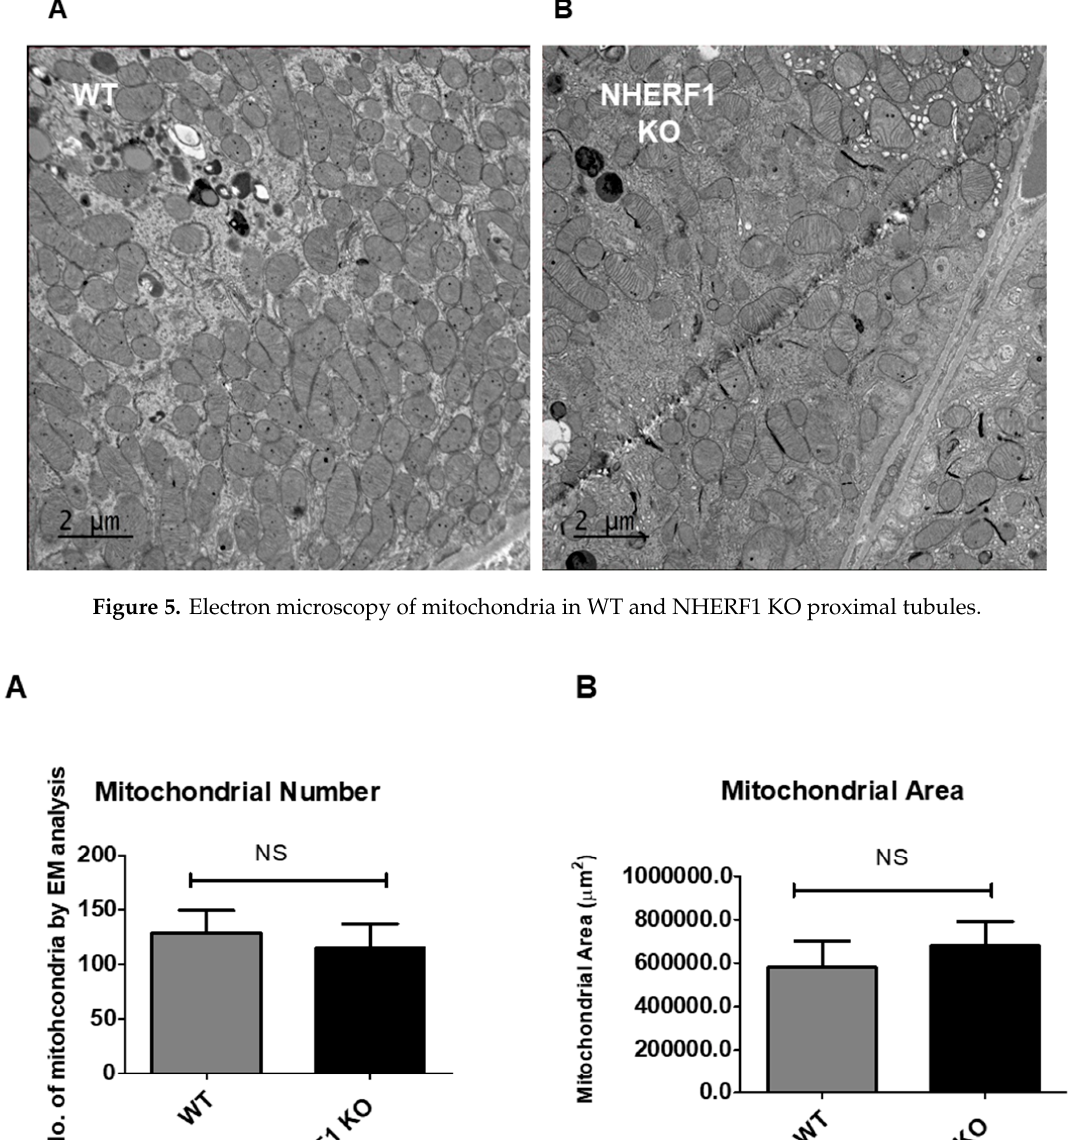
Figure 6. Evaluation of mitochondrial number and area of WT and NHERF1 KO proximal tubules. ( A ) Number of mitochondria were counted in random 4 × visual fields with the highest density of mitochondria. Data are means ± SEM (WT n = 6) and (NHERF1 KO n = 5). The mitochondria number of NHERF1 KO proximal tubules was insignificant when compared to WT. ( B ) Mitochondria area was calculated using electron microscopy (EM) images and Image J. Data are means ± SEM (WT n = 6) and (NHERF1 KO n = 5). Mitochondria area of NHERF1 KO proximal tubules were insignificant when compared to WT.